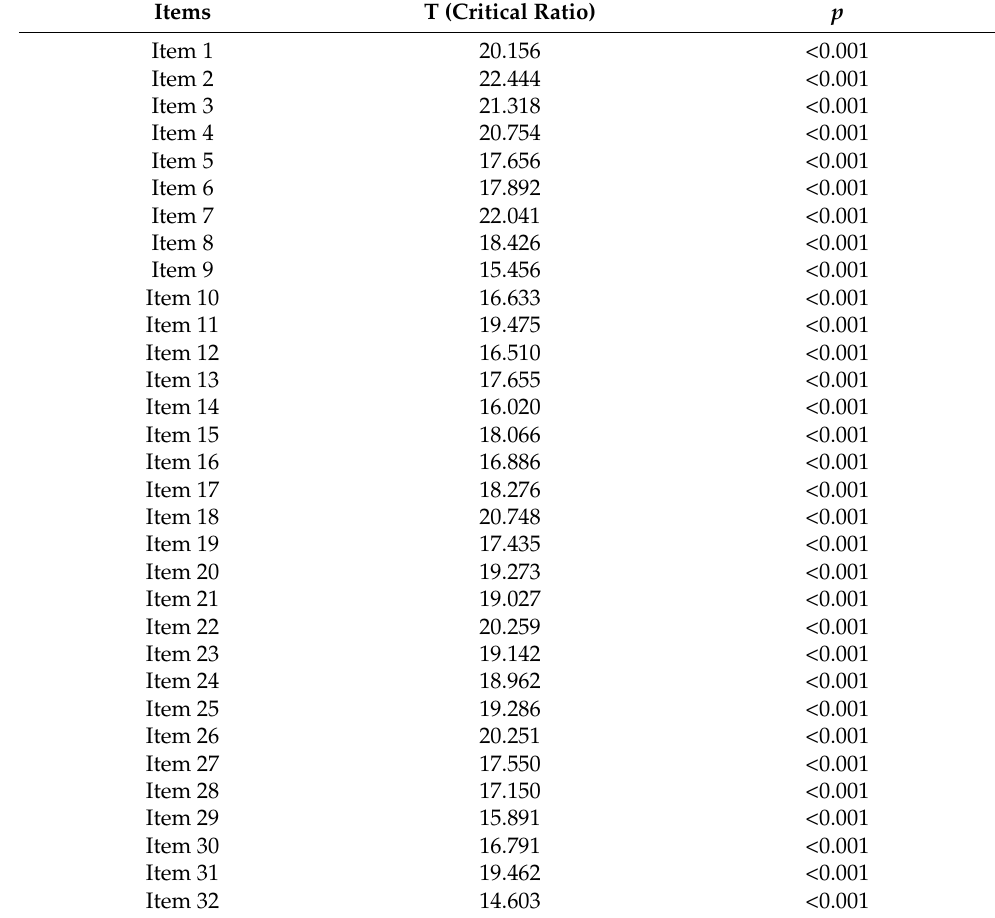
Table 1. Results of the item discrimination test.